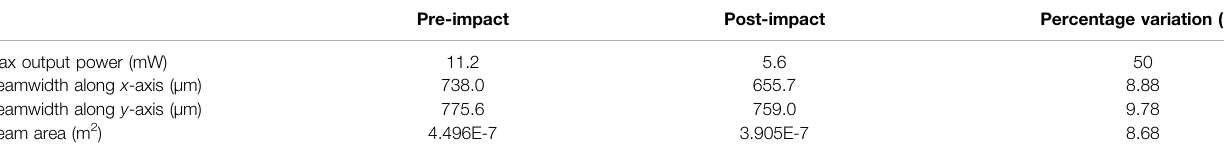
TABLE 1 | Laser diode performance comparison at the optimal voltage and current input